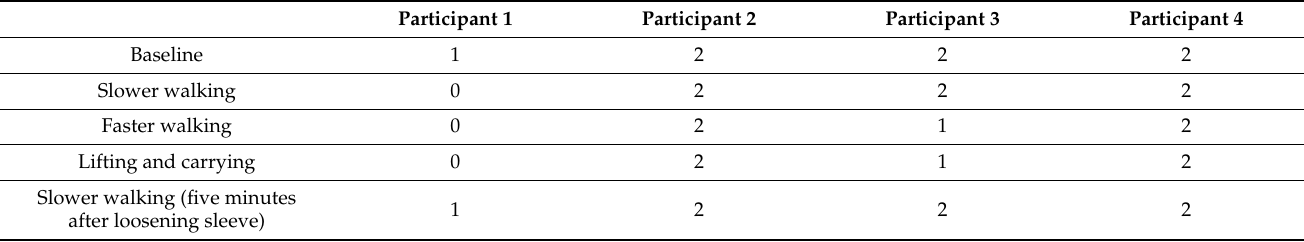
Table 5. Thermal Acceptability results for each participant for the Form-Fitting Leg Sleeve, where − 1 represents unaccept- able, 0 just unacceptable, 1 just acceptable, and 2